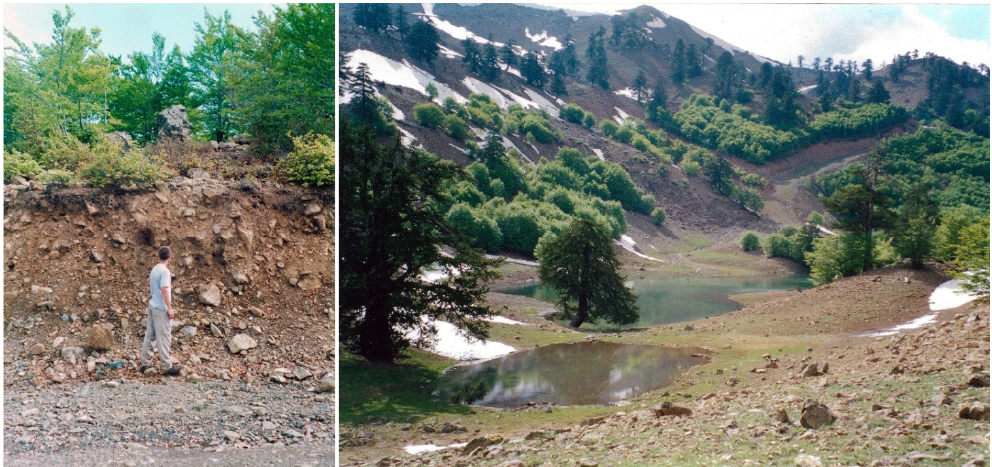
Figure 14. A section through the Smixi Member moraines at ca. 40°03 ′ 10 ″ N, 21°05 ′ 50 ″ E, 1690 m a.s.l. Note the large boulders on the surface of the moraine, which are a common feature in this area ( left ). A moraine impounding a lake to the east of Mount Vasilitsa at ca. 40°02 ′ 52 ″ N, 21°05 ′ 40 ″ E, 1790 m a.s.l. ( right ) (photographs by P. Hughes, May 2003). In the highest cirques on Vasilitsa, arcuate boulder moraines dam another lake (prob- ably ephemeral) at ca. 2000 m a.s.l. and this youngest moraine unit is identified as the Vasilitsa Summit Member. These moraine ridges represent a discrete glacial advance dur- ing a later glacial phase. East of the summit of Vasilitsa, moraine ridges also exist in a small hollow at ca. 40°02 ′ 20 ″ N, 21°05 ′ 50 ″ E, 1730 m a.s.l. These deposits represent the East Vasilitsa Member. As this is the sole unit, these deposits also represent the East Vasilitsa Formation. Two main crests can be identified. No moraines were located down-valley, although lower glacial deposits may have been eroded [68]. The stratigraphy of the glacial sequence on Vasilitsa is summarised in Table 2. The lowest and most extensive moraines are Middle Pleistocene in age whilst only the highest cirque moraines were formed by small glaciers during the Late Pleistocene (Last Glacial Cycle). All of the chert artefacts reported in this paper have been found on the Middle Pleistocene moraines. Table 2. Chronostratigraphy and morpho-lithostratigraphy of the moraine sequence in the north- eastern valley of Mount Vasilitsa. From Hughes (2004). Chronostratigraphy/Age